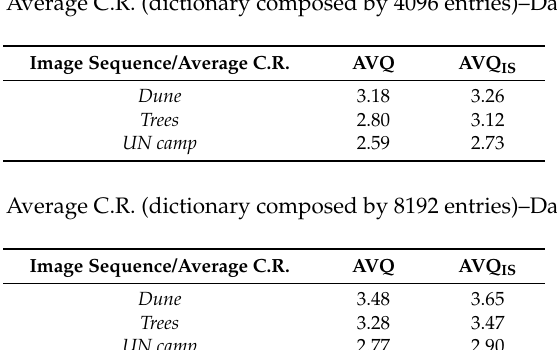
Table 7. Average PSNR (dictionary composed by 4096 entries)–Dataset 2.